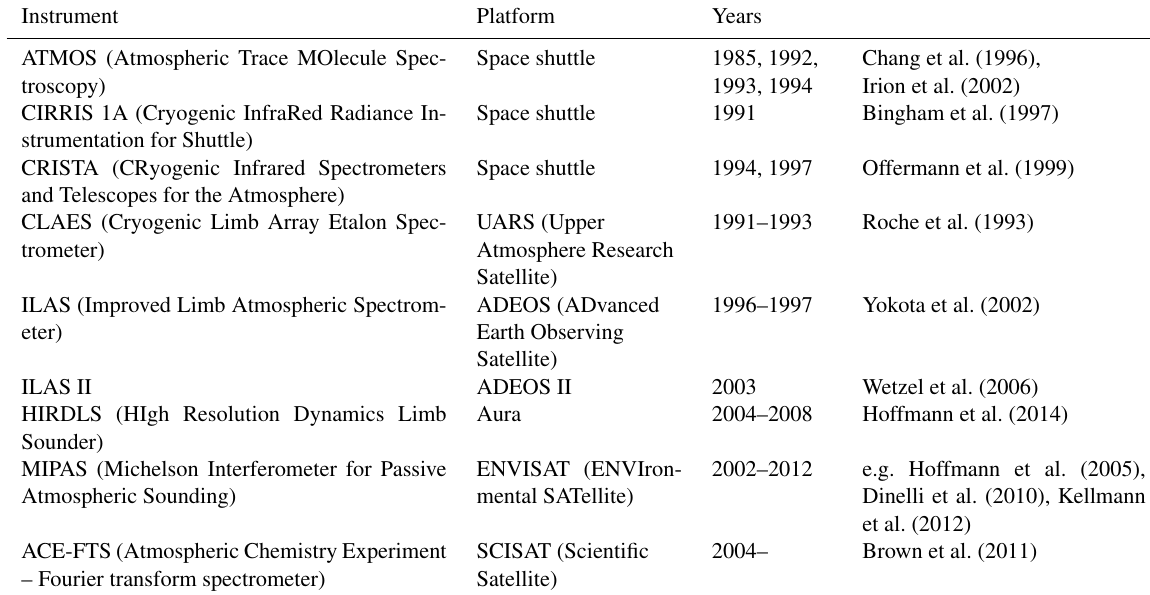
Table 1. Summary of limb sounders past and present capable of measuring CFC-11.